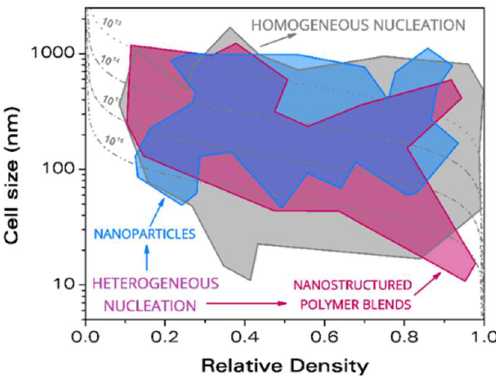
Figure 4. Comparison between the materials that have been produced taking advantage of homo- geneous and heterogeneous nucleation (from reference [50] ) . neous and heterogeneous nucleation (from reference